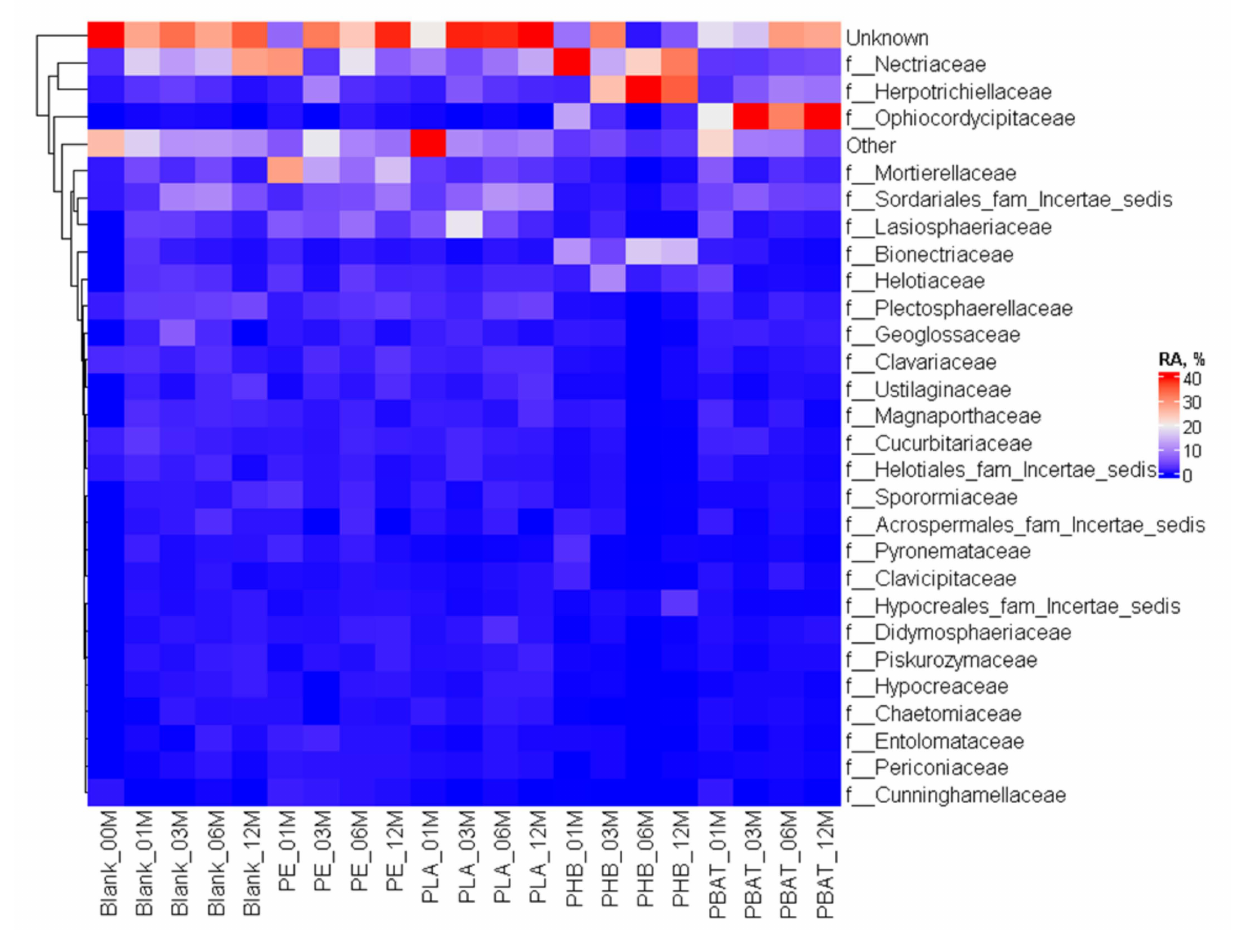
Figure 11. Heatmap of the fungal community composition and time evolution at the family